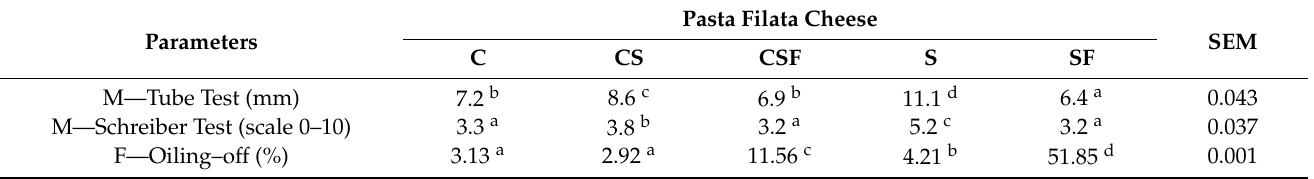
Table 4. Meltability (M) and flowability (F) parameters of pasta filata cheeses from cow’s and sheep’s frozen milk.